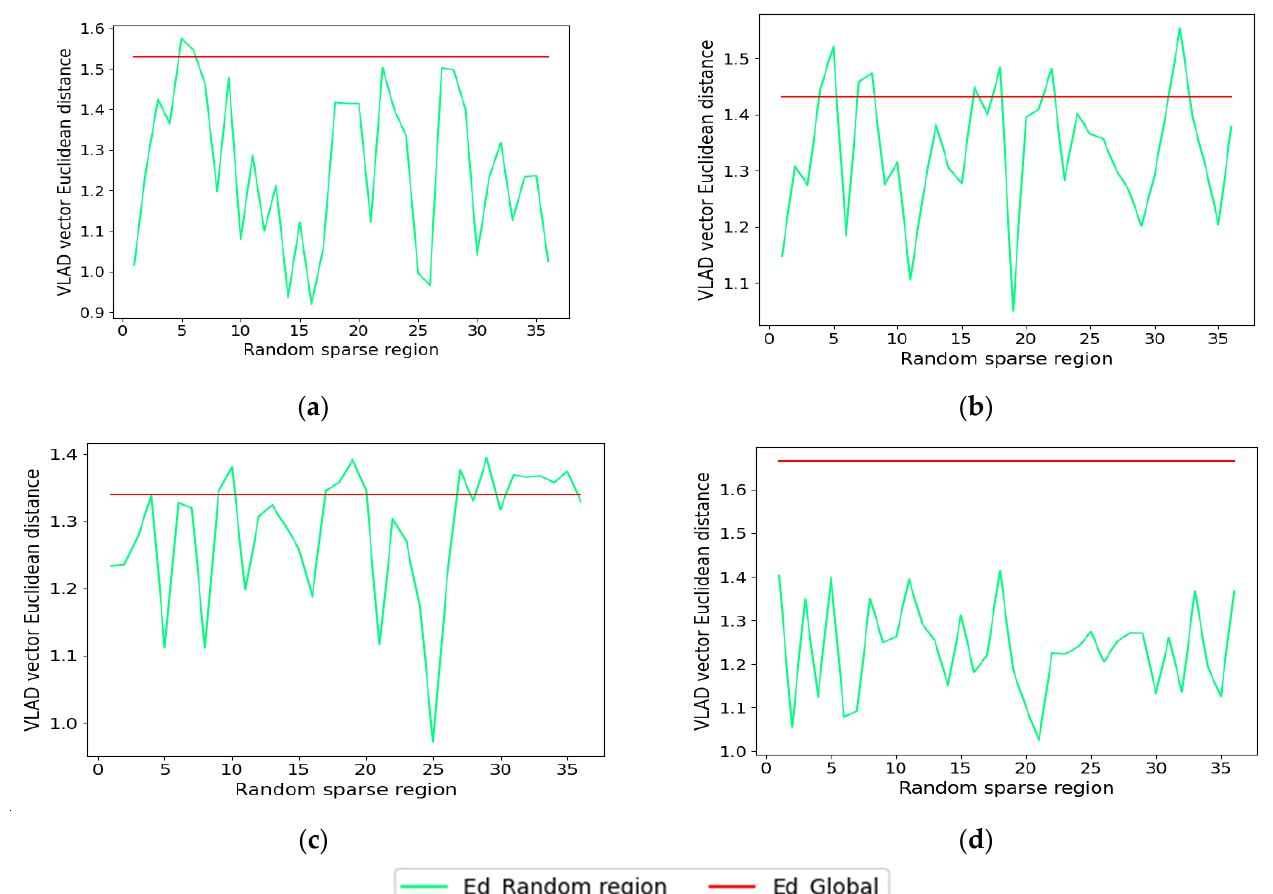
Figure 9. Similarity of paired feature-sparse regions: ( a ) image pair a, ( b ) image pair b, ( c ) image pair c, and ( d ) image pair d.